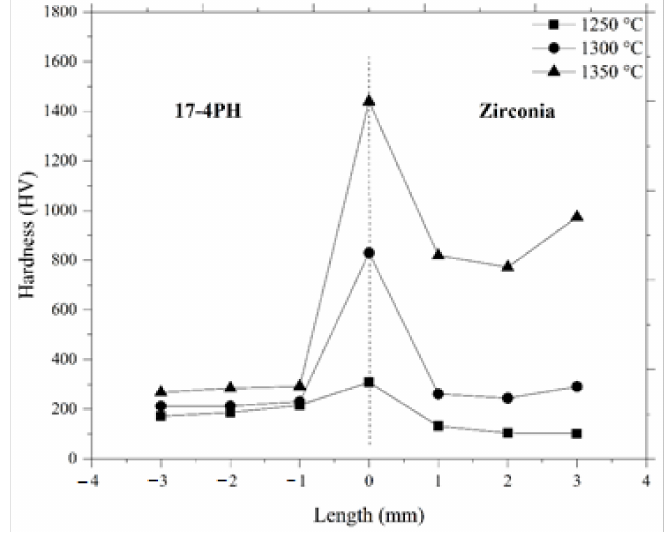
Figure 12. Hardness values of 17-4PH/zirconia micro-parts sintered at different temperatures.